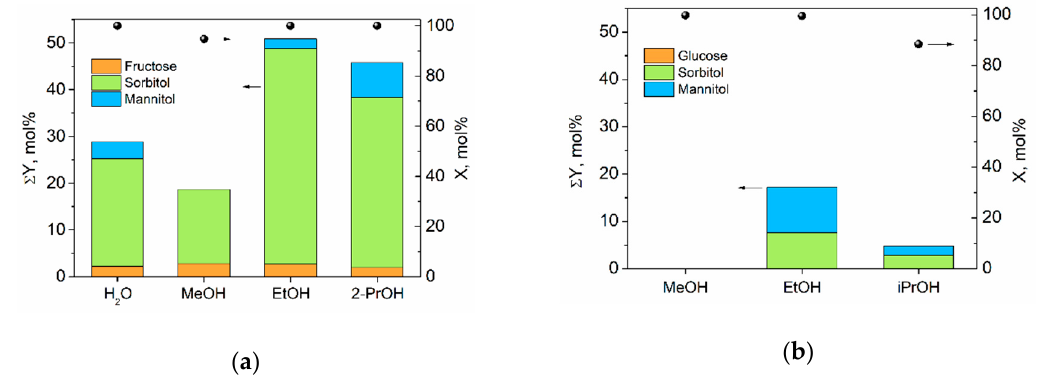
Figure 1. Cumulative product yields ( left axes) and substrate conversion ( right axes) in the catalytic transfer hydrogenation of ( a ) glucose and ( b ) fructose, with different solvents in the presence of Raney nickel catalysts. Reaction conditions: temperature = 150 °C; substrate concentration = 90 mM; substrate to catalyst mass ratio = 1:1; reaction time = 6 h.